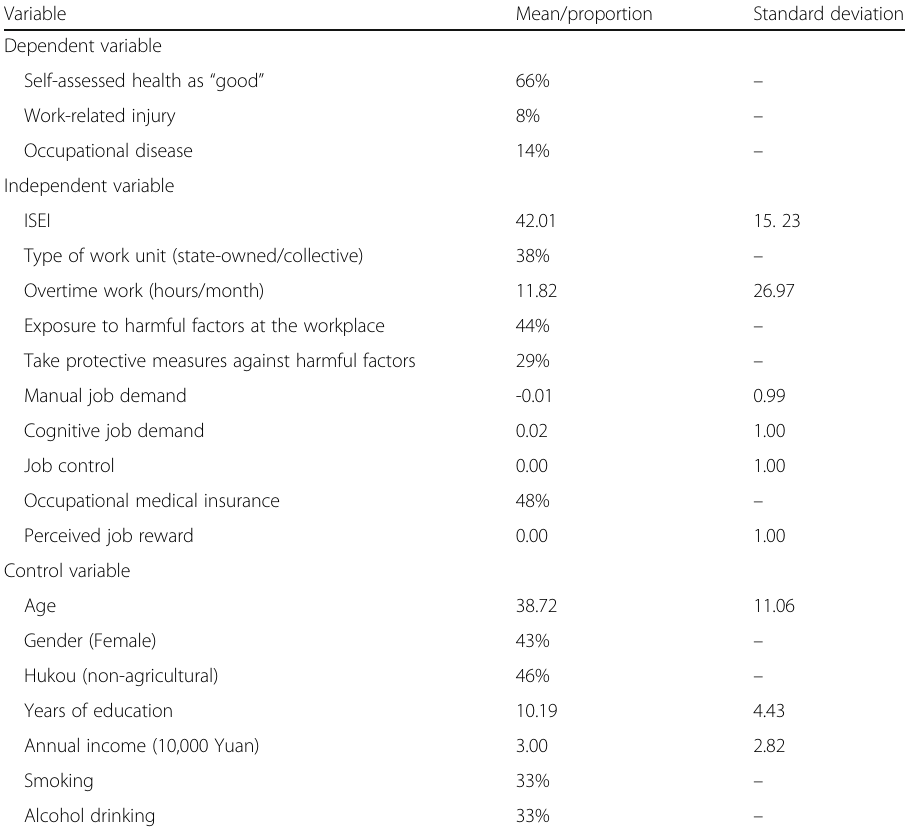
Table 1 Descriptive statistics of the main variables ( N = 3940)